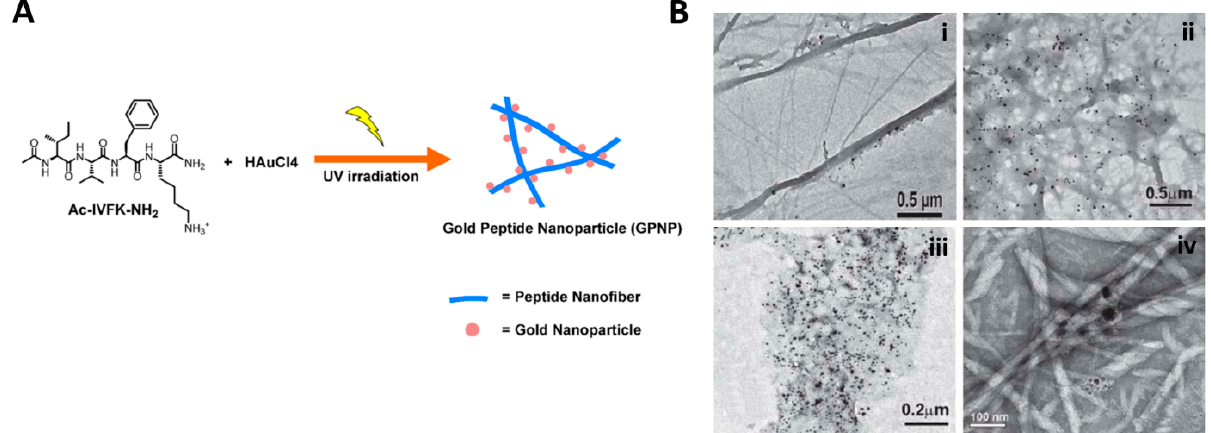
Figure 4. ( A ) Chemical structure of the tetramer peptide and fabrication of AuNPs composites with 254 nm light (adapted from reference [110]). ( B ) TEM images of AgNPs synthesized within self-assemblies of amphiphiles (i) + (H 3 C) 3 -Trp-CONH-C 16 H 33 , (ii) + (H 3 C) 3 -Tyr-CONH-C 16 H 33 , (iii) C 15 H 31 -CO-Val-Trp-COO − and (iv) C 15 H 31 -CO-Ile-Trp-COO - . Adapted from reference [108], with permission from Royal Society of Chemistry, 2022.